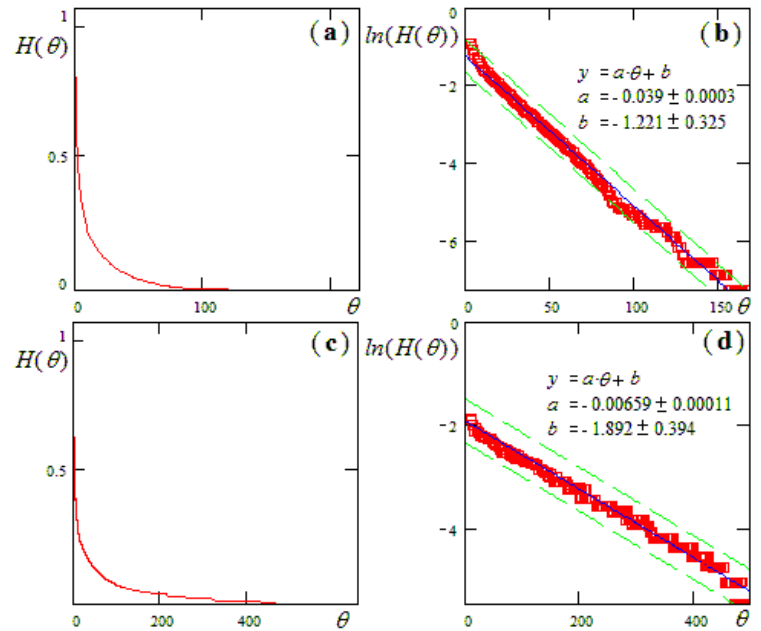
Figure 13: The fit of the cummulative distribution H ( θ ) of the switching time parameter θ for the Gillespie stochastic simulation: (a)-(b) the monomer case; (c)-(d) the multimer